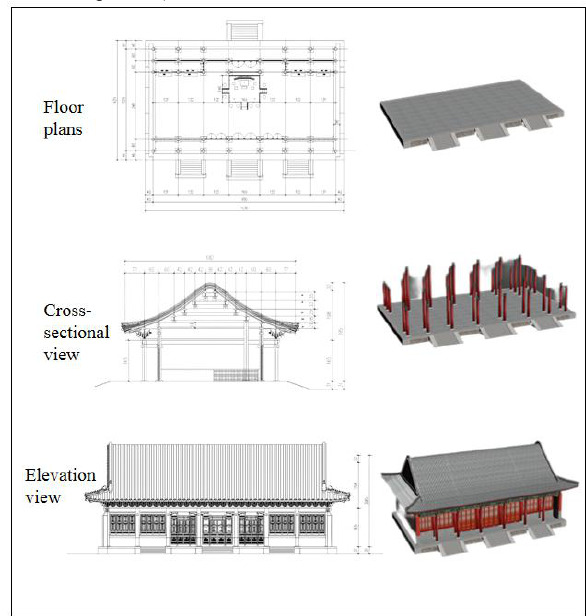
Figure 4 . Diagram of the restoration process of the Jiujing Sanshi Hall